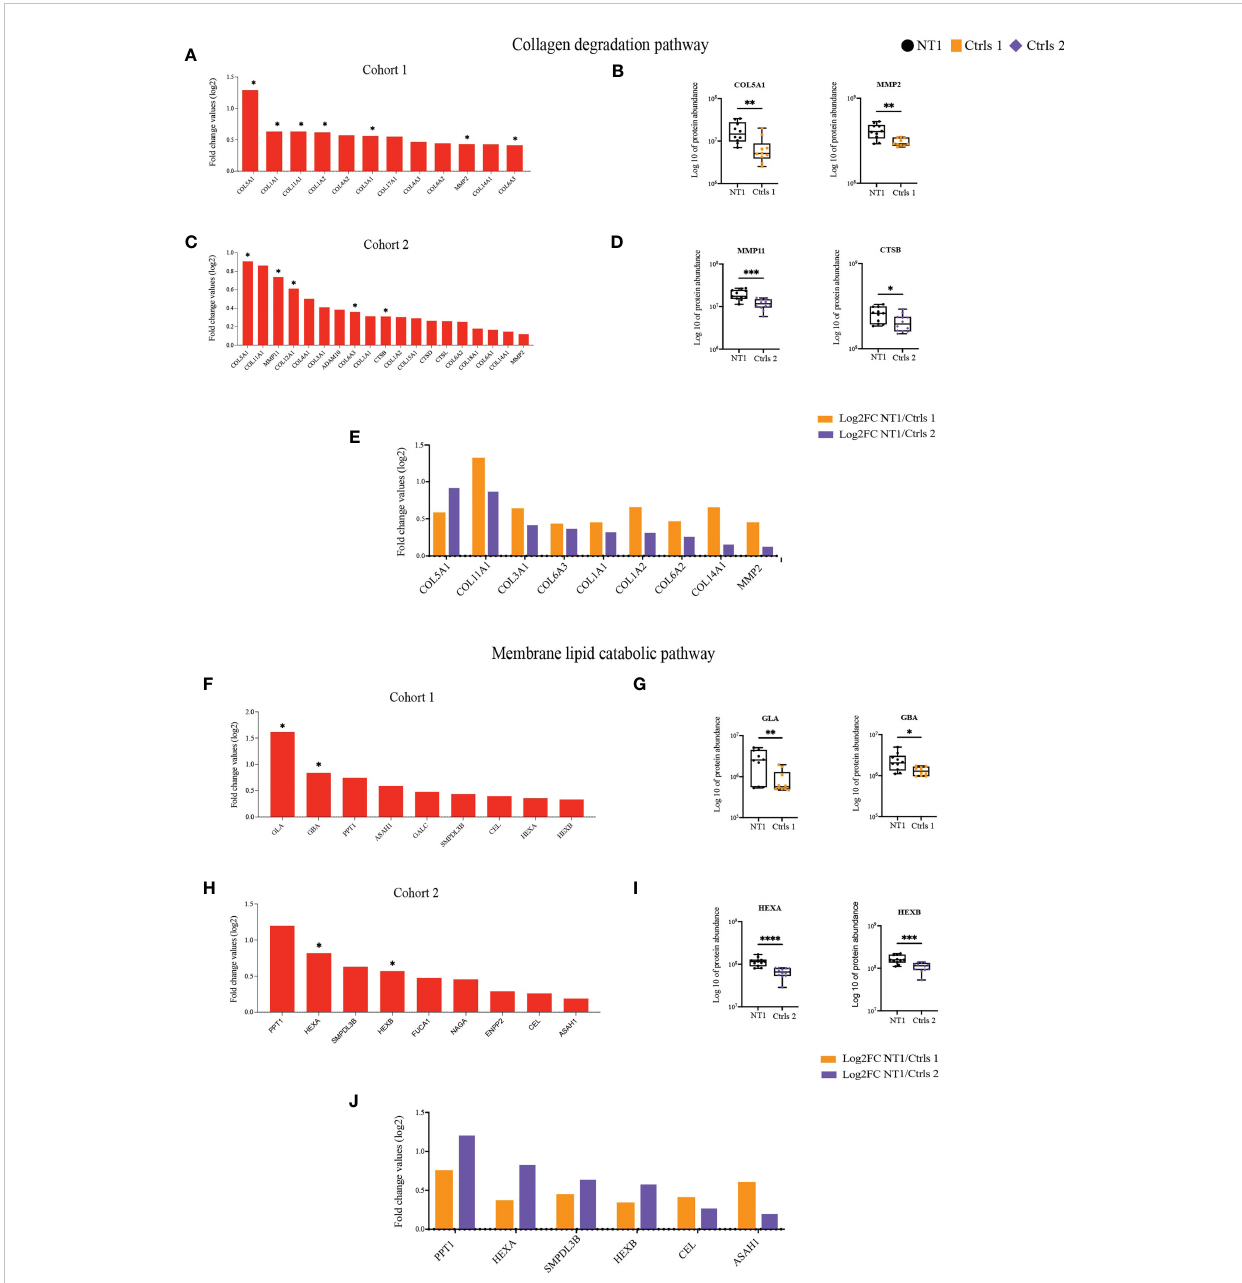
FIGURE 4 Increased abundance of proteins involved in collagen and lipid degradation in the CSF of NT1 patients. (A) The proteins involved in the collagen degradation pathway, their log2 fold change ratio in cohort 1 and (B) boxplots of selected proteins. (C) The proteins involved in the collagen degradation pathway, their log2 fold change ratio in cohort 2 and (D) boxplots of selected proteins. (E) Shared collagen degradation proteins between cohort 1 and cohort 2 and their log2 fold change. (F) The proteins involved in the membrane lipid catabolic pathway, their log2 fold change ratio in cohort 1 and (G) boxplots of selected proteins. (H) The proteins involved in the membrane lipid catabolic pathway, their log2 fold change ratio in cohort 2 and (I) boxplots of selected proteins. (J) Shared membrane lipid catabolic proteins between cohort 1 and cohort 2 and their log2 fold change. P-values in (A, C, F, H) are calculated using the Limma test. P-values in (B, D, G, I) are calculated with the Mann-Whitney test. *p-value<0.05, **p-value <0.01, ***p-value<0.001,